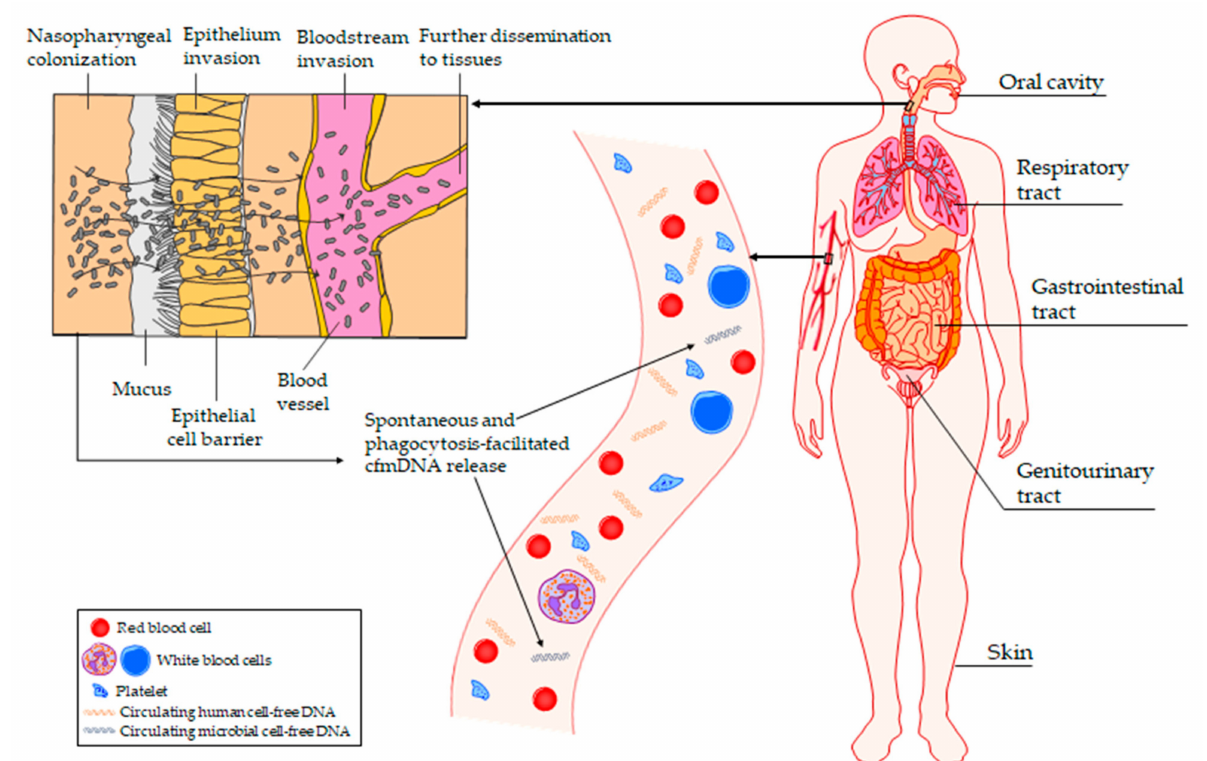
Figure 1. Microorganisms colonizing various body niches, including gastrointestinal, respiratory, and genitourinary tract, oral cavity, and skin, may translocate into the bloodstream through impaired epithelial barrier, as a consequence of toothbrushing, dental treatment, medical procedures, skin injuries, and body